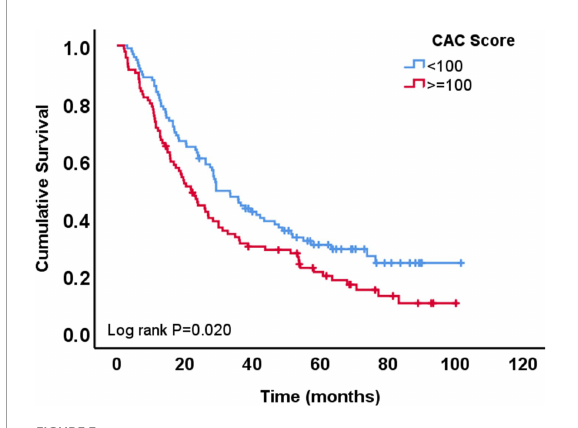
FIGURE3 Overall survival of patients with coronary artery calcium (CAC) score < 100 AU vs. those with ≥ 100 AU.